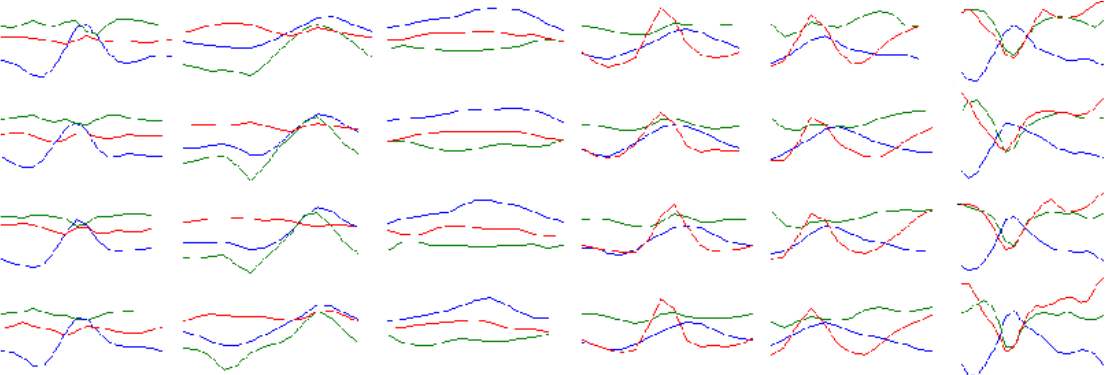
Figure 4. Examples of the six discovered exercises. Each column demonstrates four examples of the six exercises discovered from the 32 exercise sessions. Examination of the peaks and valleys reveals the temporal variability between the